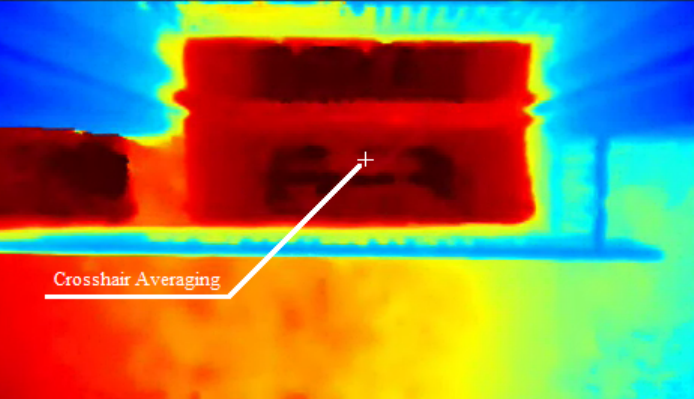
Figure 4. The crosshair which is averaged from the processed depth frame to obtain the final depth